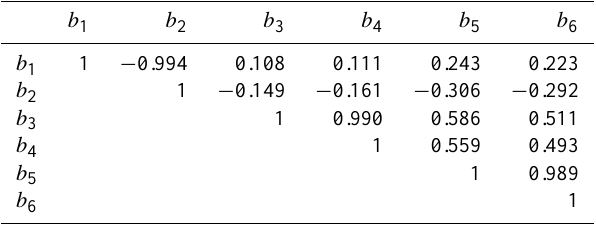
Table A2. Symmetric linear correlation matrix of fit parameters of Eq. (2) (full compaction, no fluid flow). The number of fit- ted simulations is n = 78; χ 2 = 15945.1; variance of residuals is 221.5kgm − 2 ; linear correlation coefficient for GHI from model simulations and fitted equation is r 2 = 0.9939.